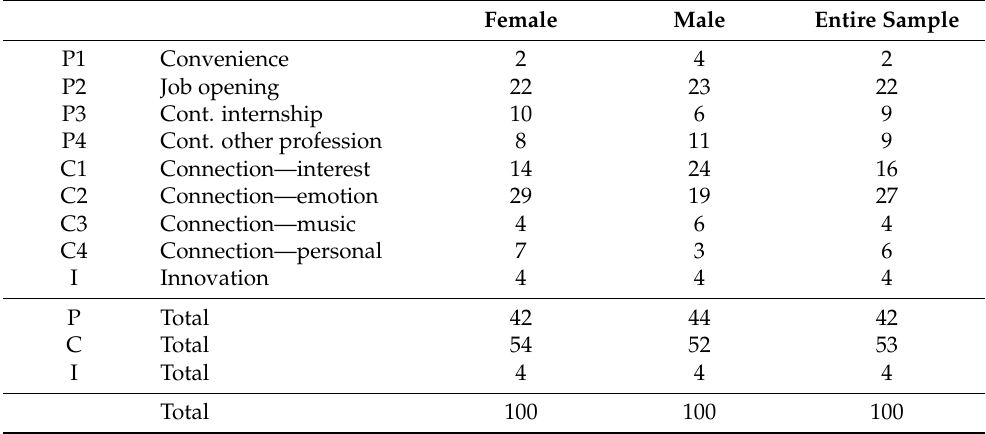
Table 3. Percentage of times that different reasons for working with clientele were mentioned: cate- gories, subcategories in entire sample and according to gender (female and male music therapists).